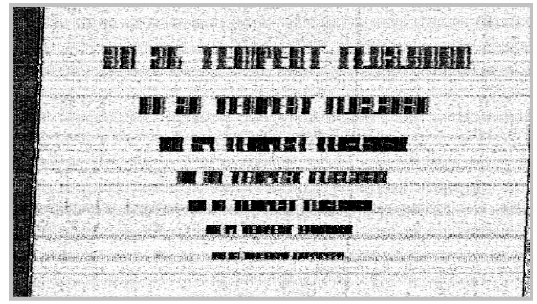
Figure 13. Image recovered when secure asymmetrical font with upper case letters was displayed. Color coding in RGB format (red, green and blue) is done by combining in some proportions these 3 primary colors, with values between 0 and 255. Thus, the blue color is coded for example [0,0,255] or “0000FF” in hexadecimal format (HEX) while black is represented by [0,0,0] or "000000" (HEX) and the white color of [255,255,255] or "FFFFFF" (HEX). The inverted video option practically means